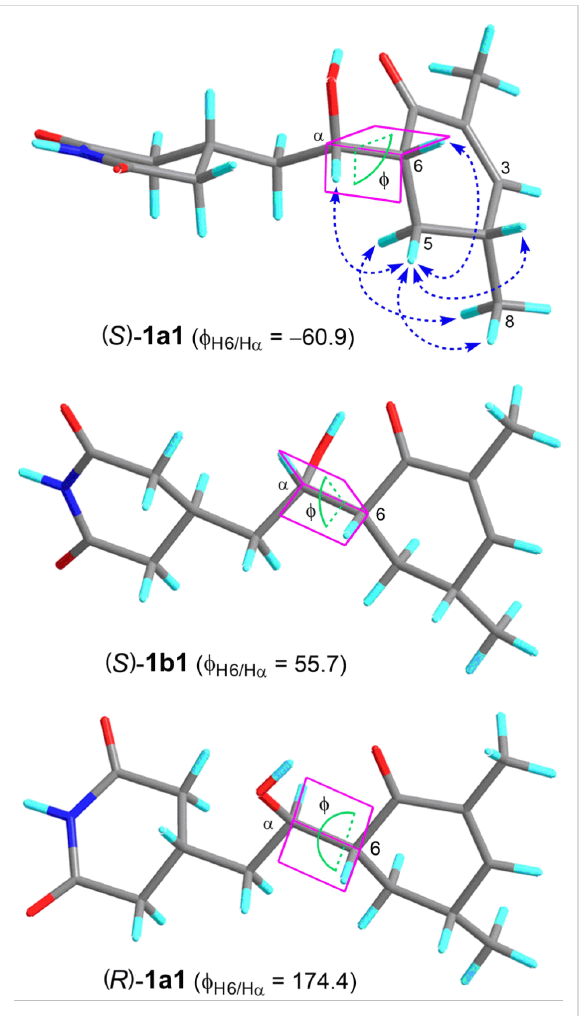
Figure 2: Representatives of the theoretical dominant conformers of (4 R ,6 R , α S )- 1 (( S )- 1a1 and ( S )- 1b1 ) and (4 R ,6 R , α R )- 1 (( R )- 1a1 ) in equilibrium populations (in MeOH) and key NOESY correlations (dashed arrows) of 1 .